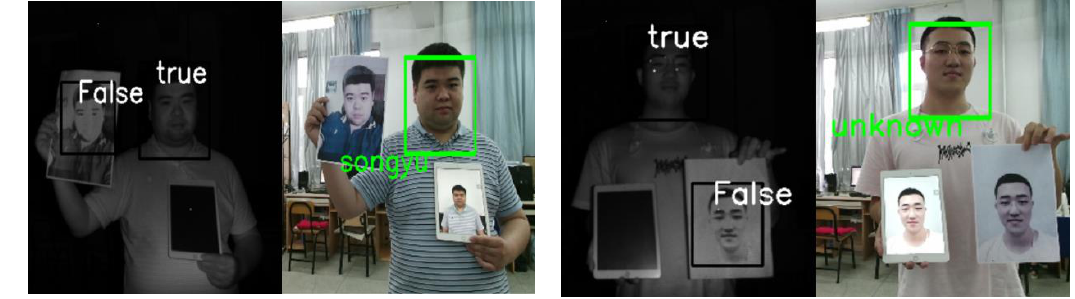
Figure 10. Integrated test.